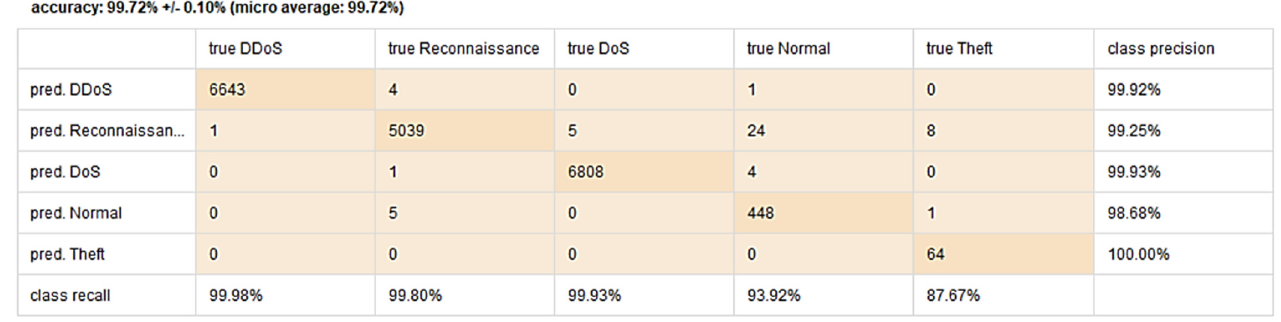
Figure 5. Confusion matrix of kNN-IG.